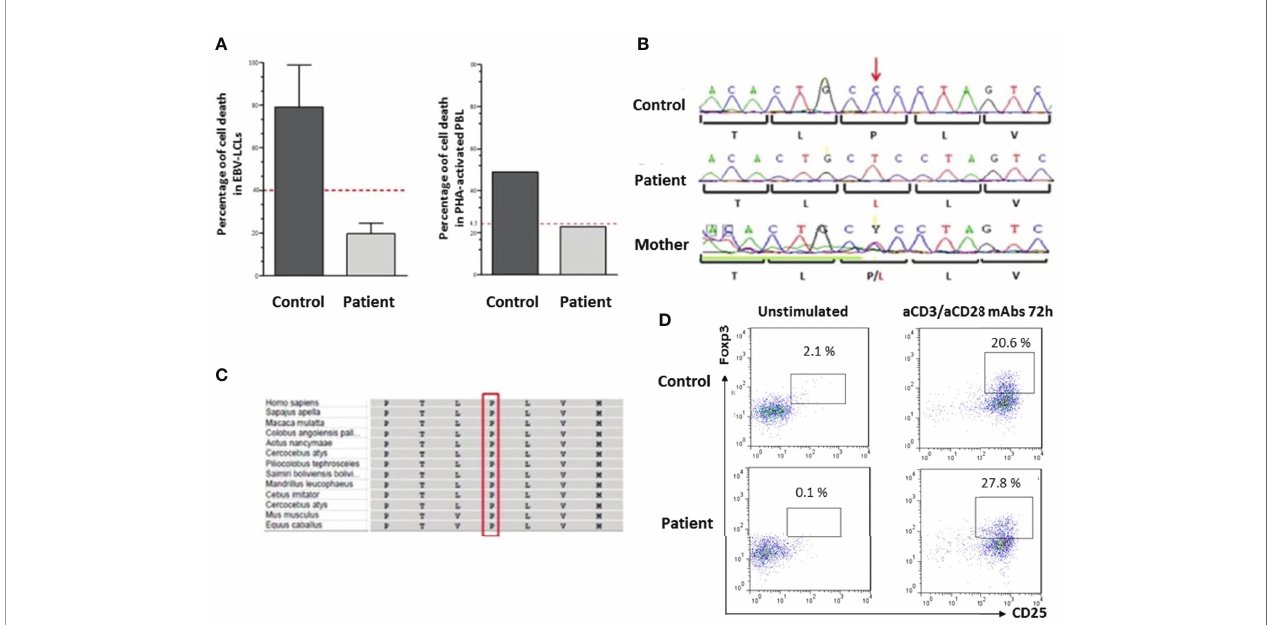
FIGURE 2 | Genetic and functional investigations (A) Apoptosis assay: The IPEX patient exhibits a signi fi cantly altered apoptosis. Fas-induced apoptosis in EBV- lymphoblastoid cell lines (EBV-LCL) or PHA-activated peripheral blood lymphocytes of the patient and a healthy control were stimulated for 24 h with or without APO-1-3 in the presence of protein A. Subsequently apoptosis was measured by fl ow cytometric detection of Annexin V-PE and 7AAD. For apoptosis in EBV-LCL, data represent two separate experiments and the T bars indicate the standard deviation. The dotted red line represents 50% of the cell death observed in the control. (B) Genomic DNA sequence analysis of FOXP3 gene showing a missens hemizygous mutation p.Pro75Leu in the patient, the mother was heterozygous for the mutation. (C) Multiple protein alignment showing the position of the conserved proline 75 residue in different species using the NCBI Multiple Sequence Alignment Viewer, Version 1.19.1. (D) FOXP3 expression in PBMCs after staining with anti-CD4/APC, anti-CD25/BB-515 and anti-Foxp3/PE as compared to healthy control. Treg cells were absent in patient ’ s unstimulated cells and induced after activation with anti-CD3 (aCD3)/anti-CD28 (aCD28) mAb during 72